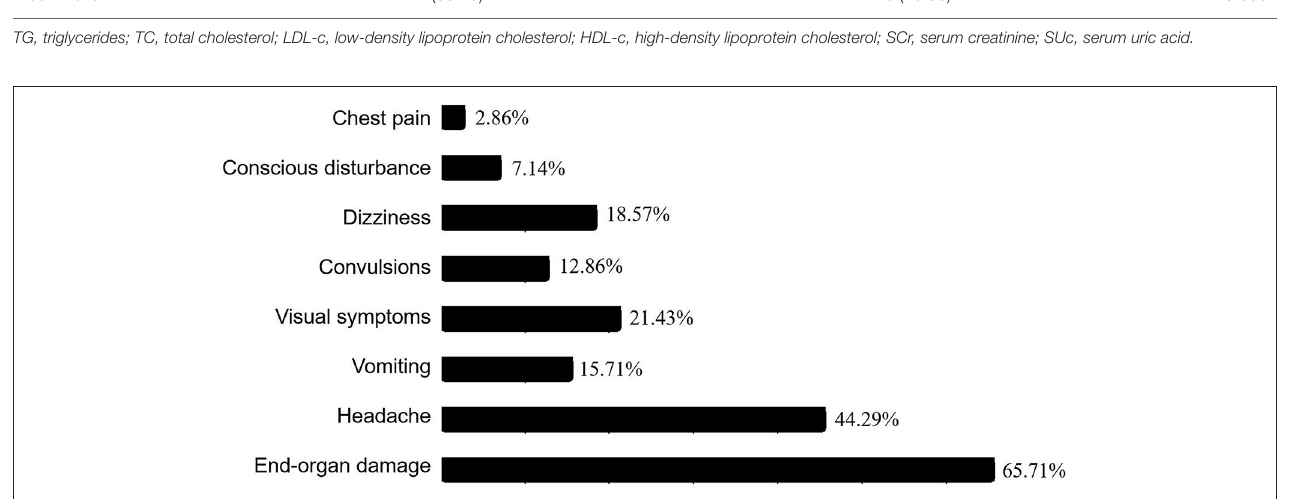
FIGURE 2 | Ratios of clinical manifestations in the pediatric patients with hypertensive crisis. Among the 70 patients with hypertensive crisis, chest pain was present in 2 cases (2.86%), conscious disturbance in 5 cases (7.14%), dizziness in 13 cases (18.57%), convulsions in 9 cases (12.86%), visual symptoms in 15 cases (21.43%), vomiting in 11 cases (15.71%), headache in 31 cases (44.29%), and end-organ damage in 46 cases